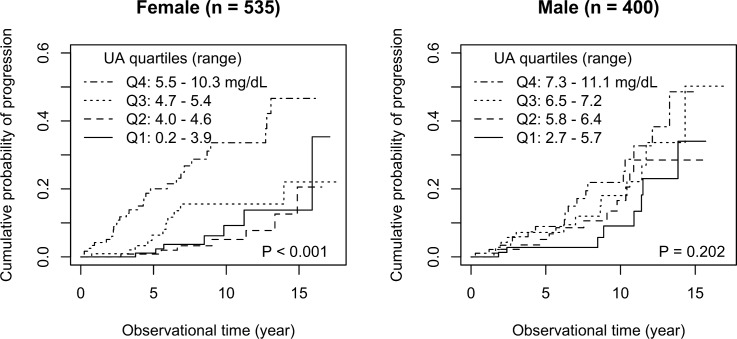
Cumulative probabilities of a 150% increase in the serum creatinine level (progression) in 535 female and 400 male patients who were stratified into quartiles based on uric acid level.